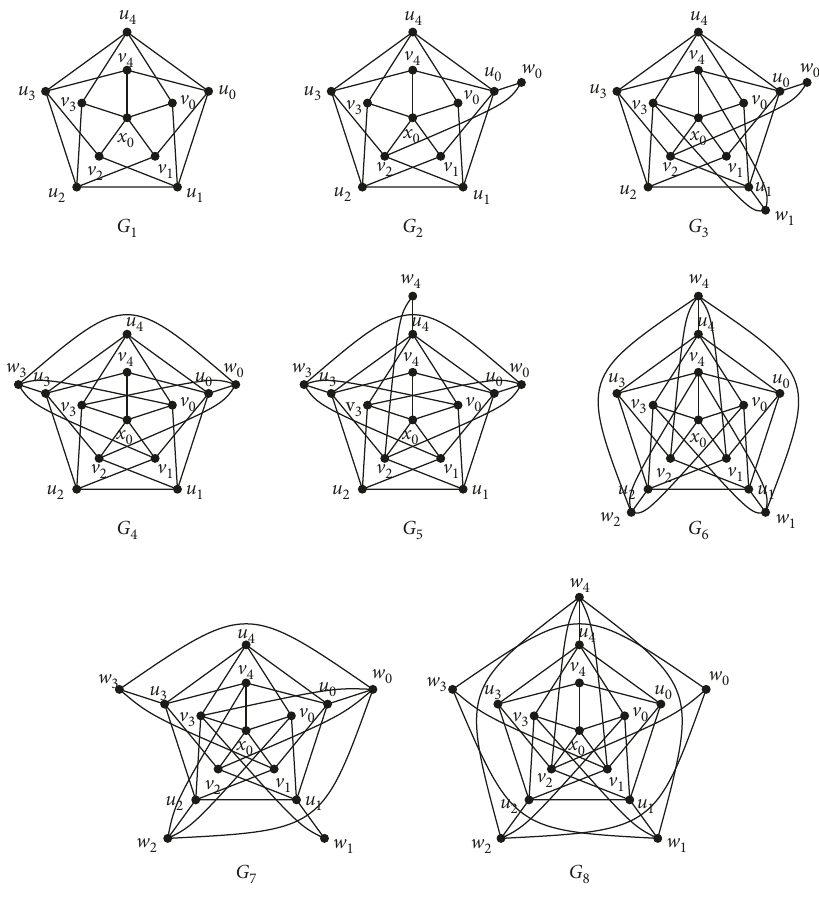
Figure 1: Eight graphs with Δ � 5 and χ �